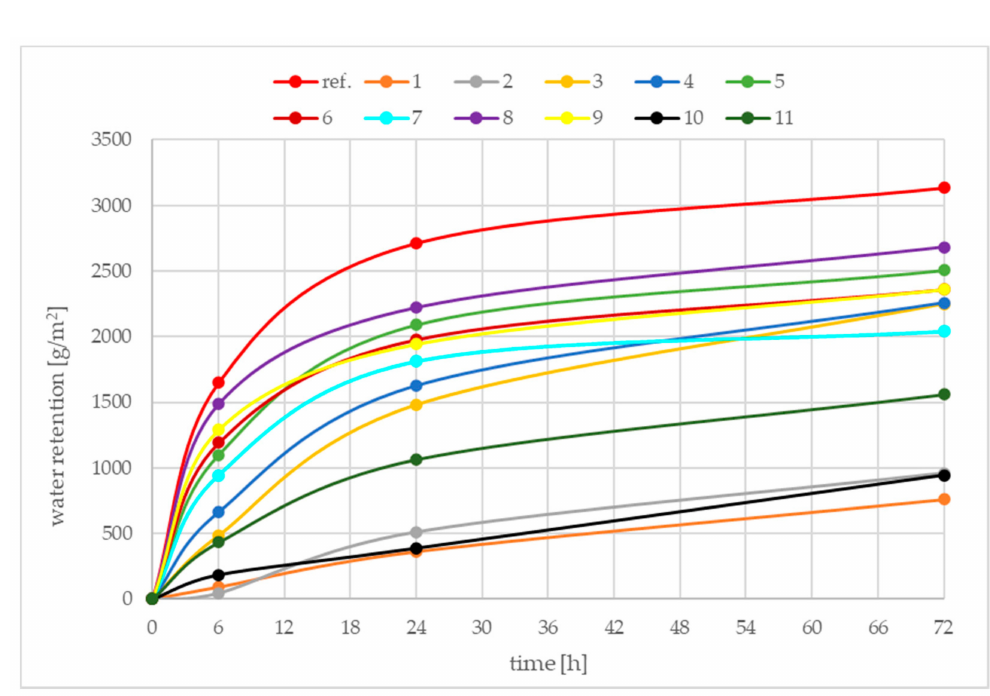
Figure 5. Water retention for all examined curing compounds samples over 72